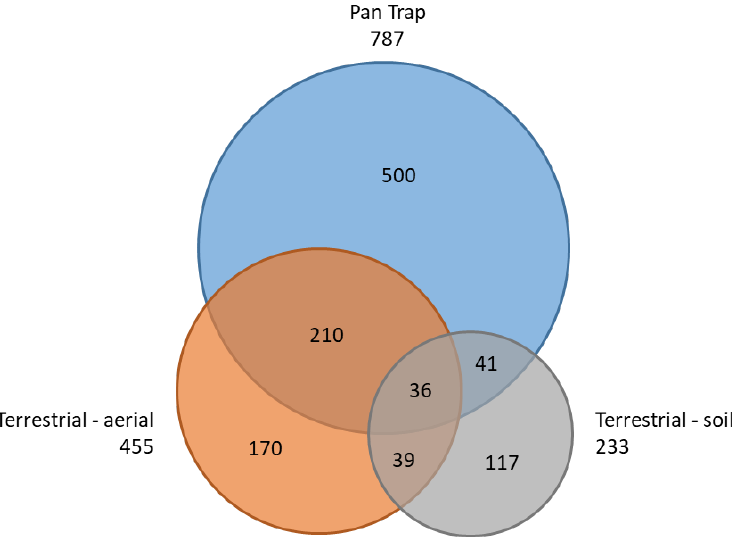
Figure 6. Venn diagram of all BINs collected among pan traps and both terrestrial active methods.